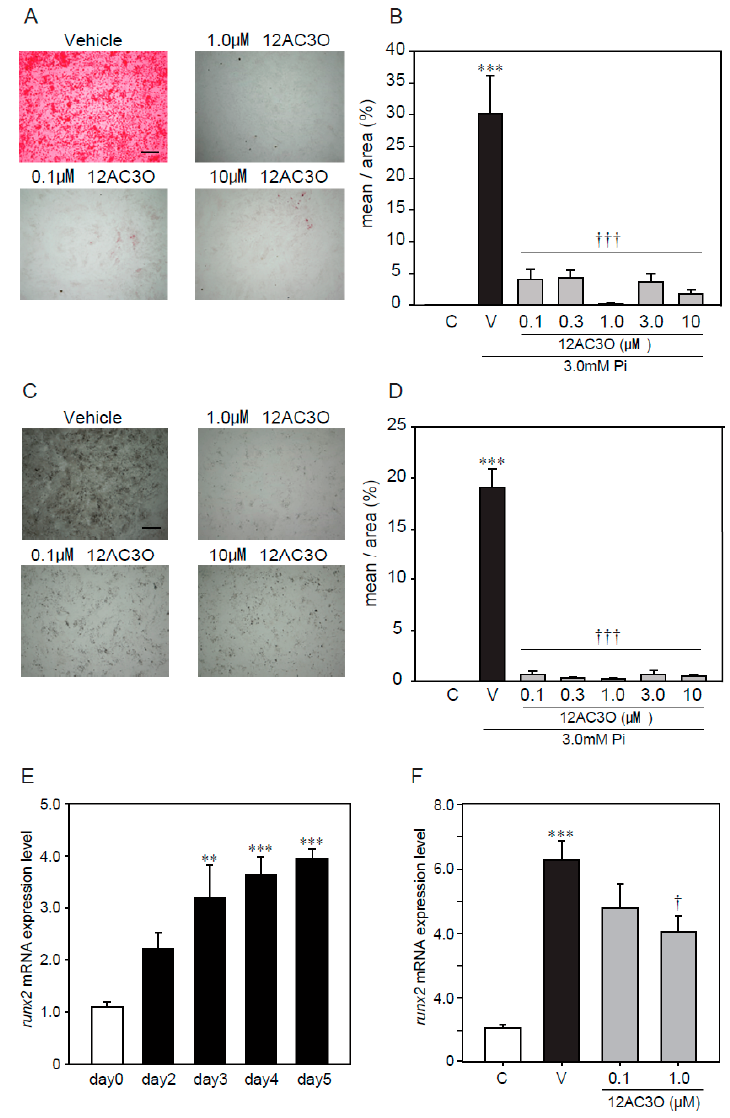
Figure 4. Protective effects of 12C3O against high Pi ‐ induced calcification. p53 LMACO1 cells were cultured with 1.0 mM Pi or FBS (+) medium as a control and 3.0 mM Pi or FBS (+) medium in the presence or absence of 12AC3O (0.1–10 μ M) for 4 days. ( A , B ) Alizarin red staining. ( C , D ) von Kossa staining. ( E ) qRT ‐ PCR analysis of the effects of Pi loading with 3.0 mM on the mRNA expression level of Runx2. ( F ) p53LMAco1 cells were treated with 3.0 mM Pi and 12AC3O (0.1 μ M, 1.0 μ M, and 3.0 μ M) for 5 days. Runx2 mRNA expression level was measured by qRT ‐ PCR. Results are presented as C: Control (1.0 mM Pi), V: Vehicle (3.0 mM Pi), ** p < 0.01, *** p < 0.001 vs. Control, † p < 0.05 vs. Vehicle,